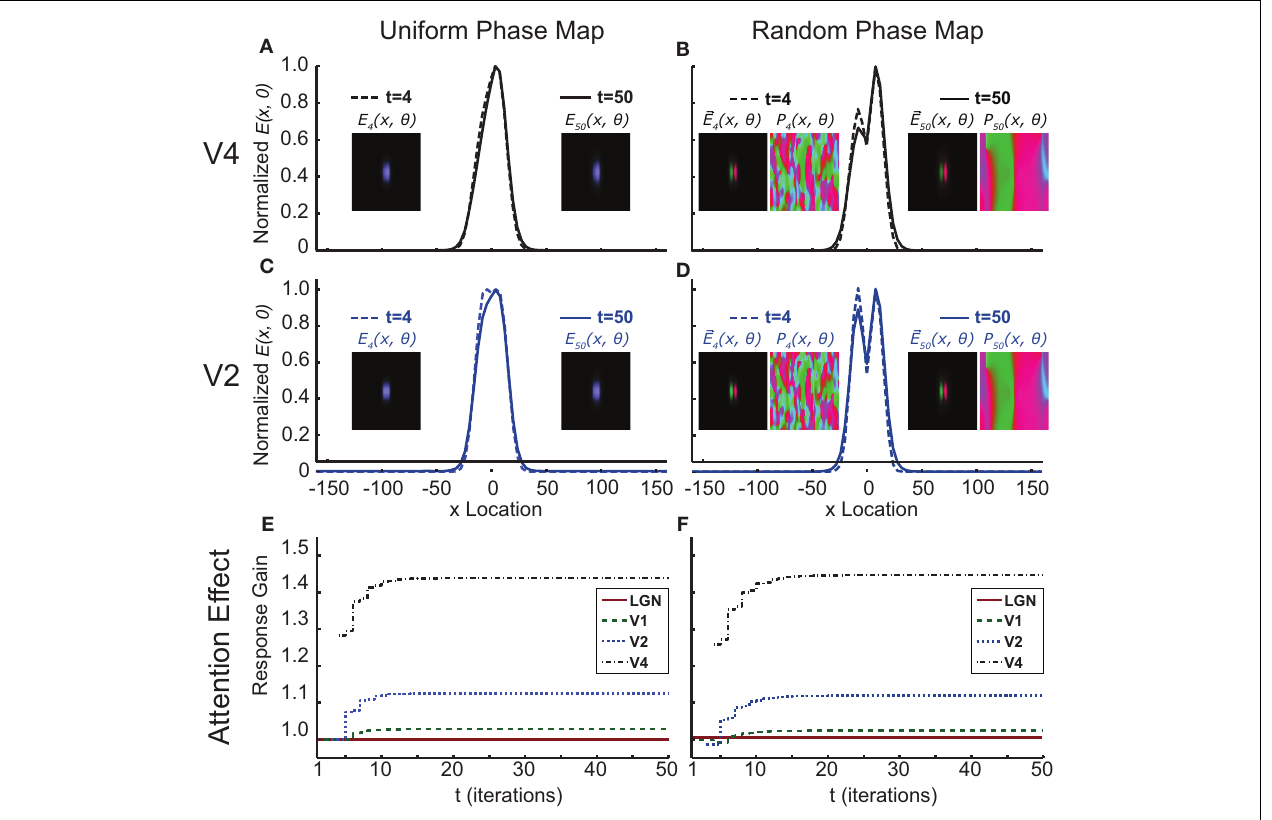
effect over time for the four simulated cortical areas.When the same simulation is run with randomized phase maps [0 − 2 π ] (B,D,F) , a clear bimodal distribution can be observed in bothV4 (B) andV2 (D) ; and both in an early phase of the simulation ( t = 4; dotted lines) and at the steady-state ( t = 50; solid lines). Also visible is that the phase maps ( P ( x , θ )) can be highly fragmented at the start of the simulation, but will converge to a highly structured bimodal division; where one half of the phase map is dominated by one stimulus, and the other half is dominated by the other. Note that adding a randomized phase map to the cascading normalization model does not qualitatively change the size, spread or temporal structure of the attentional effect [compare (E,F) ]. Colors in the phase map are calculated as follows: R = ( cos ( P ) + 1 )/ 2; G = 1 − R ; B = ( sin ( P ) + 1 )/